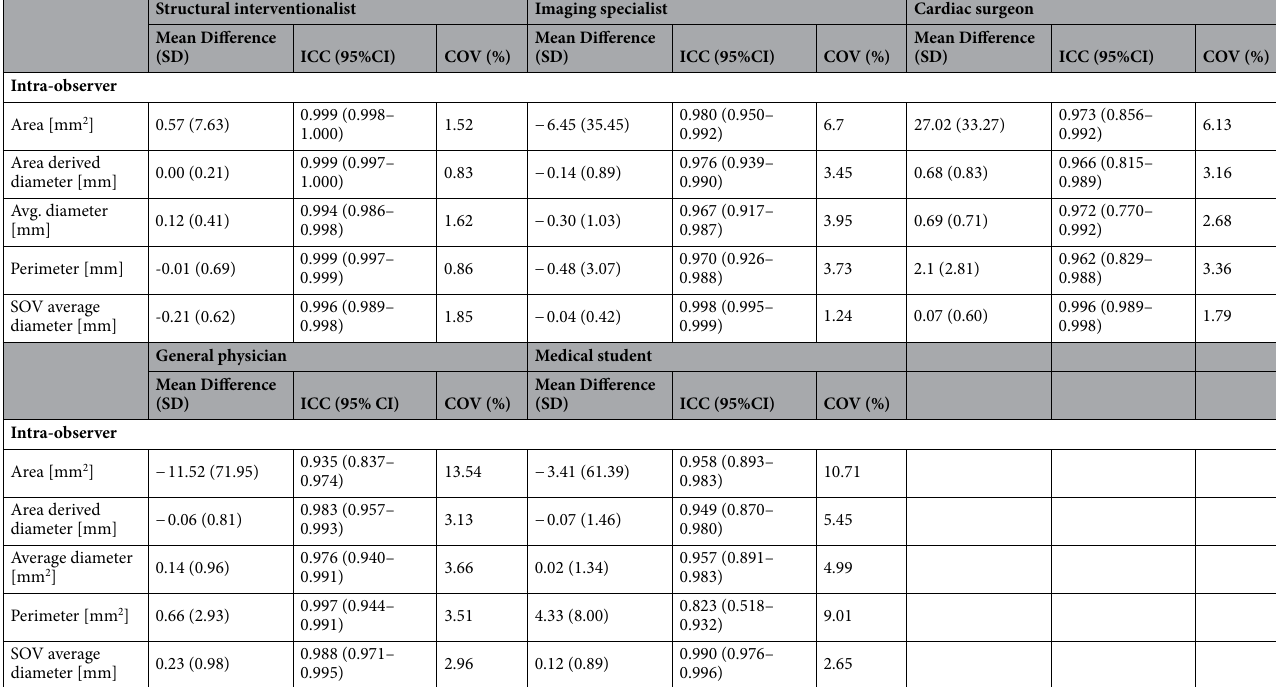
Table 5. Intra-observer agreement and reproducibility. Results are reported as mean (SD). SOV: sinus of valsalva; ICC: intraclass-correlation coefficient; CoV: coefficient of variation; SD: standard deviation; CI: confidence interval.